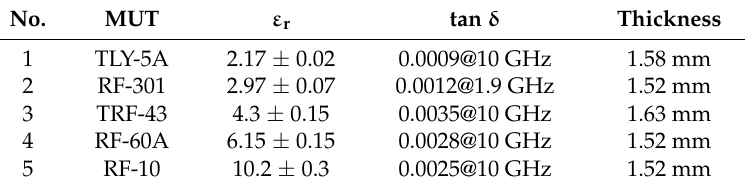
Figure 9. Experimental setup: ( a ) unloaded; ( b ) loaded. Table 2. Permittivity, loss tangent, and thickness of the five MUTs.